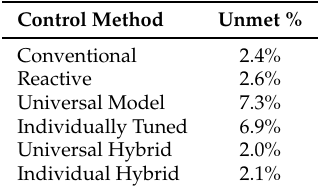
Table 10. Average discomfort by control